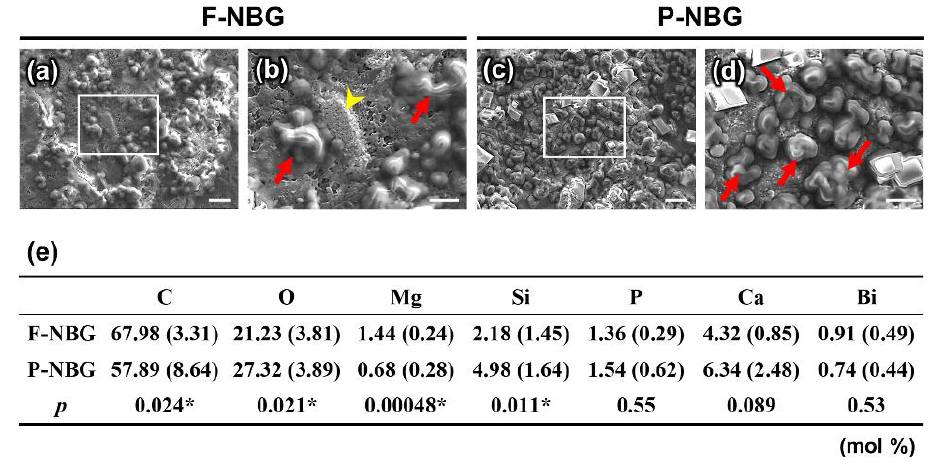
Figure 2. Phosphate ion (PO 43 − ) concentration in simulated body fluid (SBF) or 1-, 5-, or 10-g/L bovine serum albumin-containing SBF (BSA-SBF) after the immersion of flowable and putty-form Nishika Canal Sealer BG Multi (F-NBG and P-NBG). Asterisks indicate p < 0.05 (unpaired t -test, n = 6).